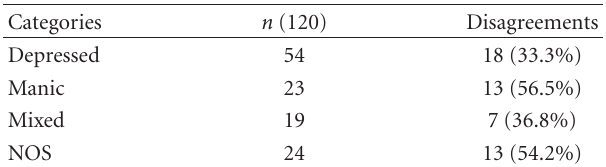
Figure 2: Percentage of diagnostic disagreements between the “pre- gold standard” diagnosis and the “gold standard” diagnosis by the total number of comorbidities. ∗ P < 0 . 10. Table 3: Frequencies of last episode type.